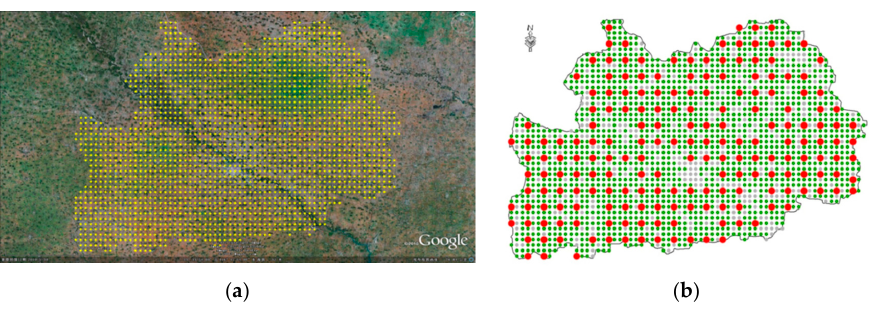
Figure 2. A grid of 0.01° was overlaid on the Google Earth imagery ( a ). There are 2074 grid